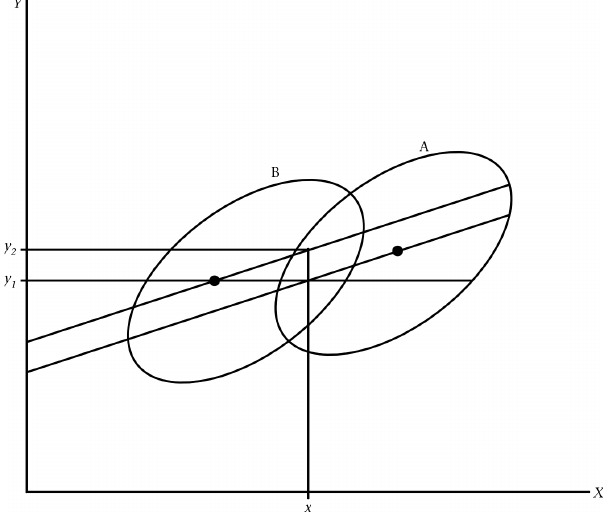
Figure 2: Predictive (intercept) bias